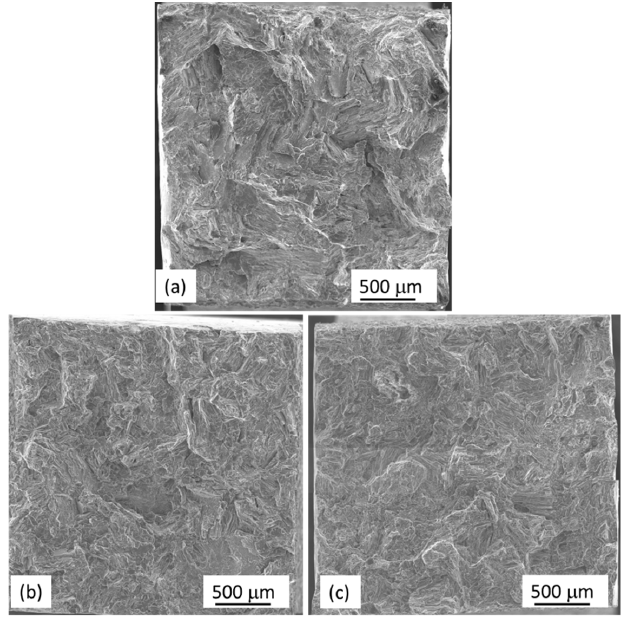
Figure 4. Fracture morphologies of WZ73 and MMCs after tensile test: ( a ) WZ73; ( b ) WZ73-1.5 vol% SiC; and ( c ) WZ73-2.5 vol% SiC.